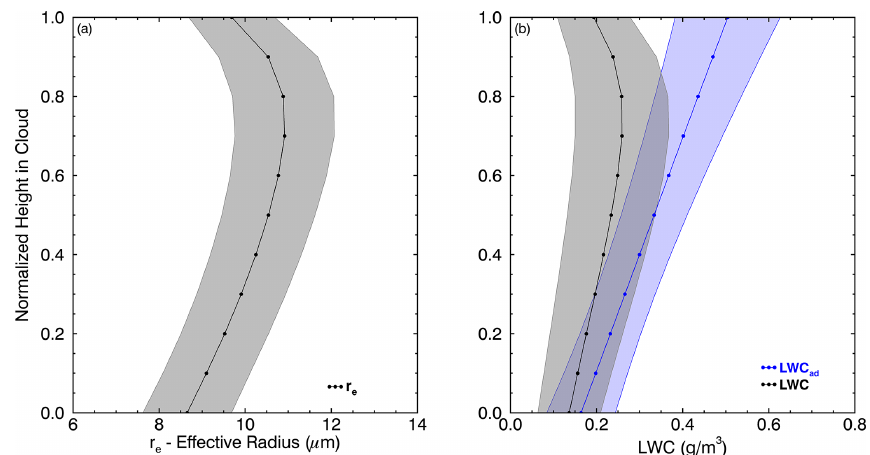
Figure 5. Normalized in-cloud vertical profiles of retrieved (a) r e and (b) LWC (black) and calculated adiabatic LWC ad (blue) for all selected cloud cases; 0 is cloud base, and 1 is cloud top. Solid lines with dots denote mean values, and shaded areas denote 1 standard deviation at each height.